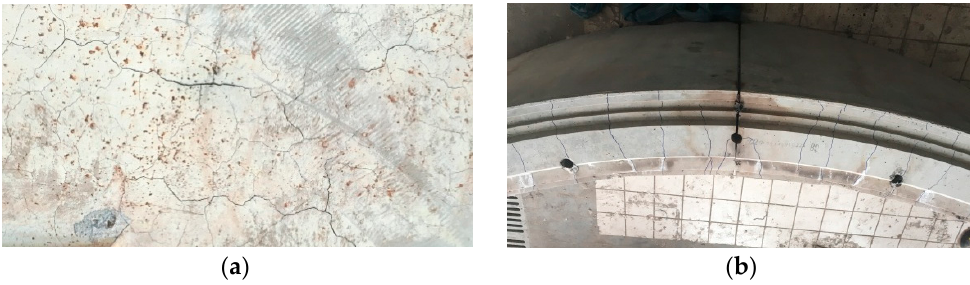
Figure 8. Cracks of specimen. ( a ) Cracks on the so ffi t; ( b ) cracks on the front and back surfaces.